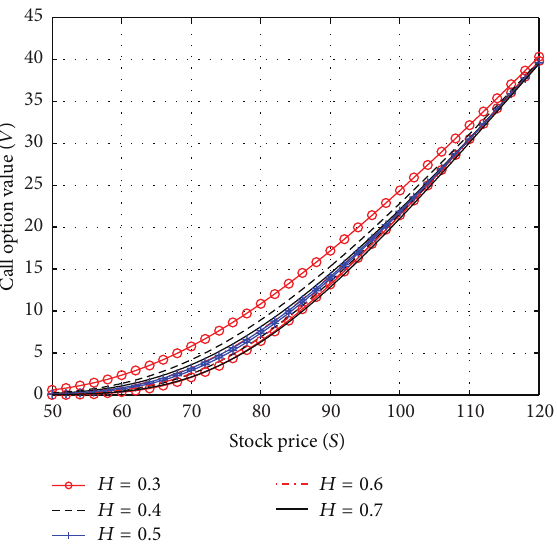
Figure 3: Asian put option pricing corresponding to the different 𝑎